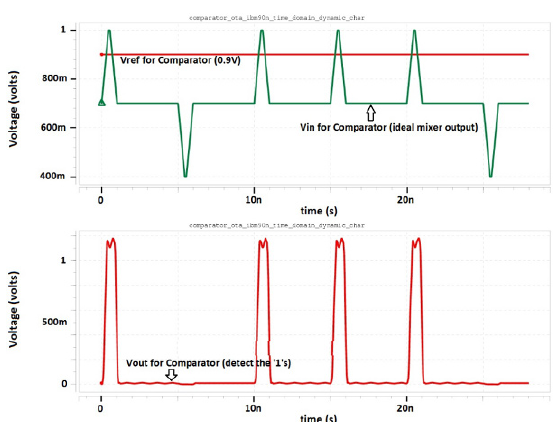
Figure 10. Step-by-step optimization of reference